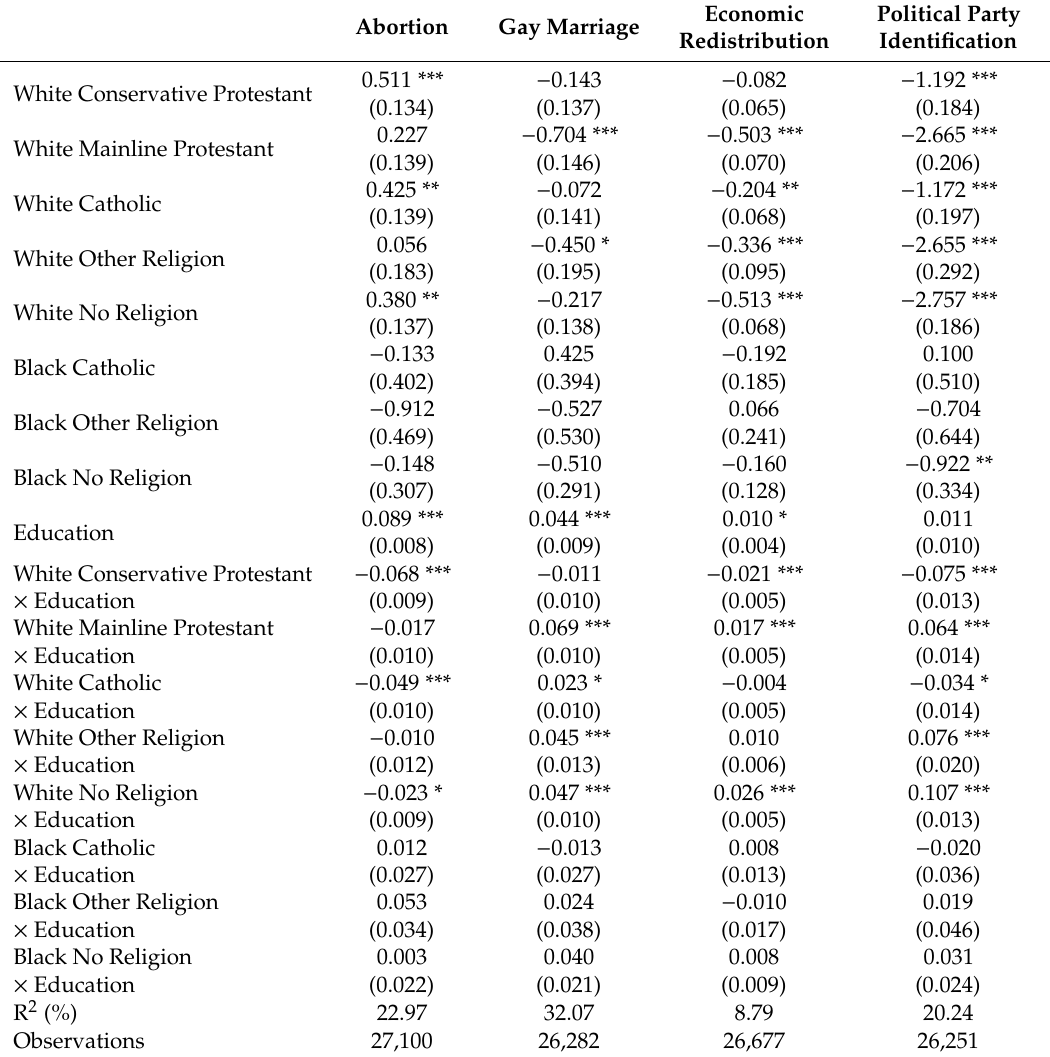
Table A1. Original results from the OLS models of examining the interaction of education, race, and religion for Blacks and Whites (Black Protestant as reference).